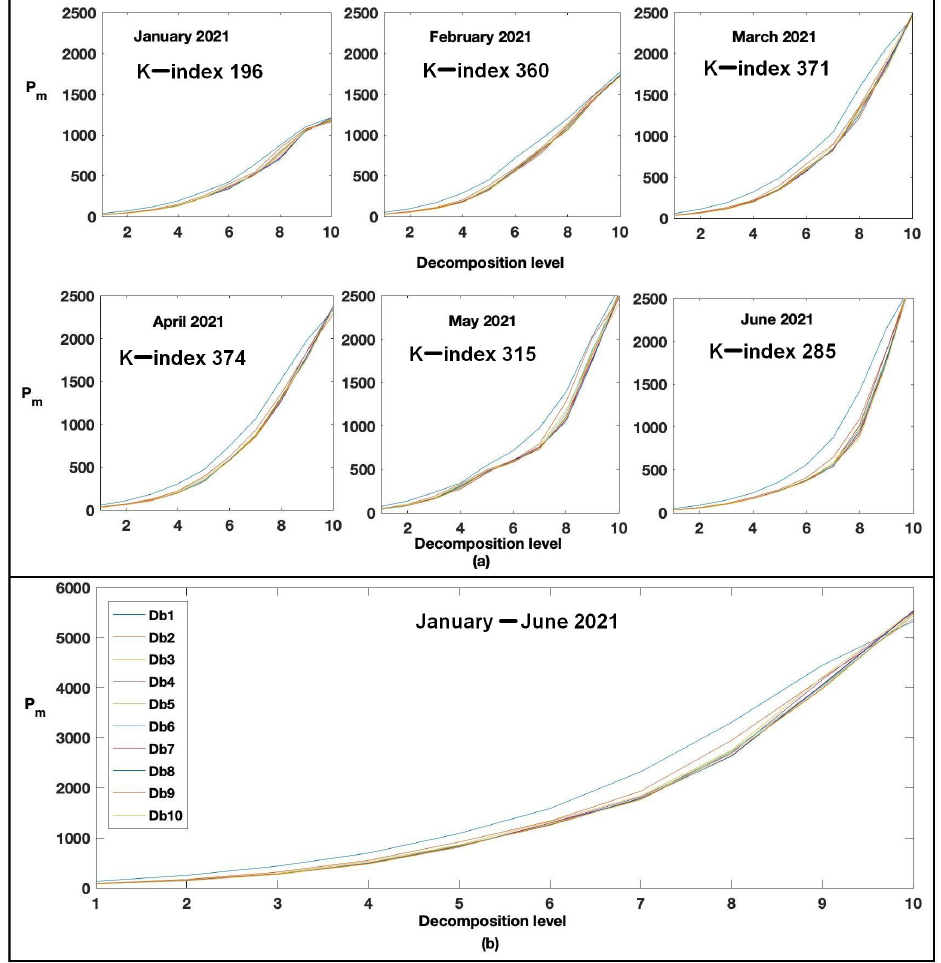
Figure 3. Processing results for geomagnetic data for the period 11–12 May 2021. ( a ) H-component; ( b , c ) application of thresholds. The red vertical line is the magnetic storm